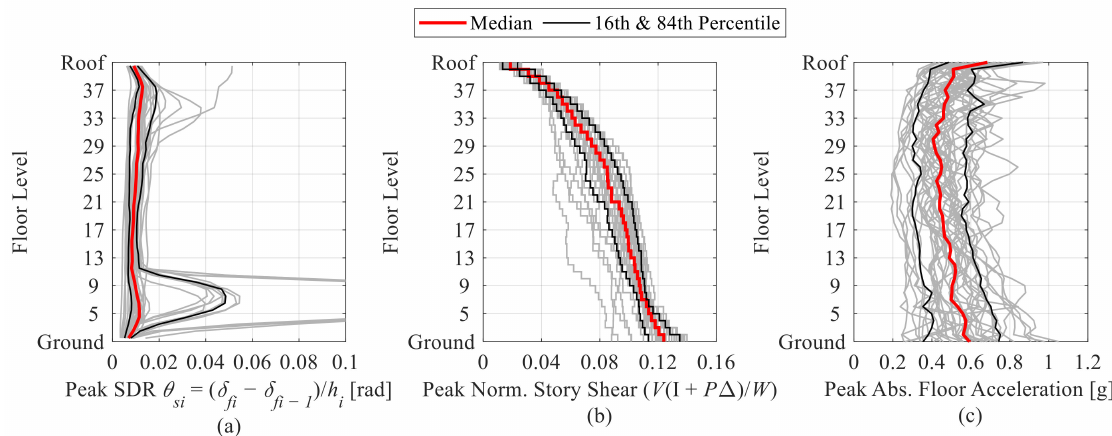
Figure 13. Engineering demand parameters of the retrofitted building (BSE-2E), ( a ) peak SDR, ( b ) peak normalized story shear force, ( c ) peak absolute floor acceleration.